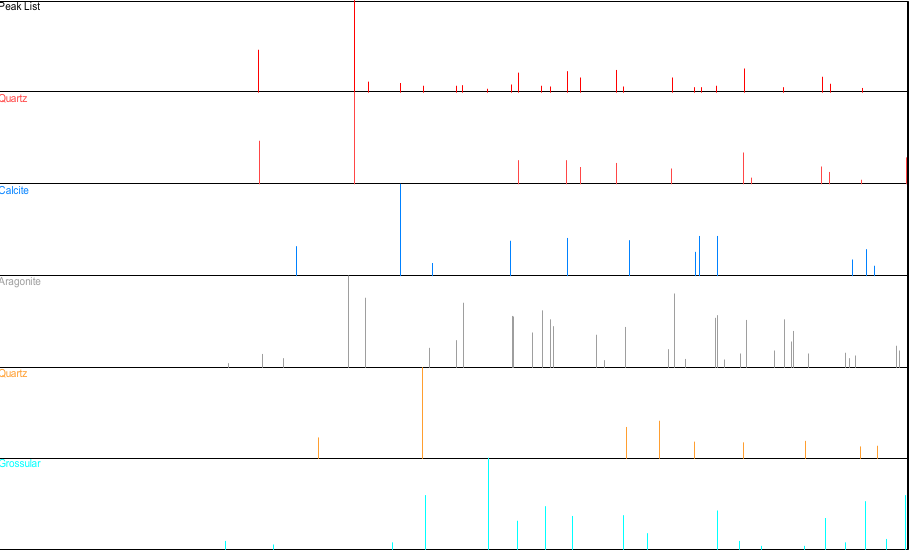
Figure 17. Structural X-ray (XRD) results of the autoclaved bricks.